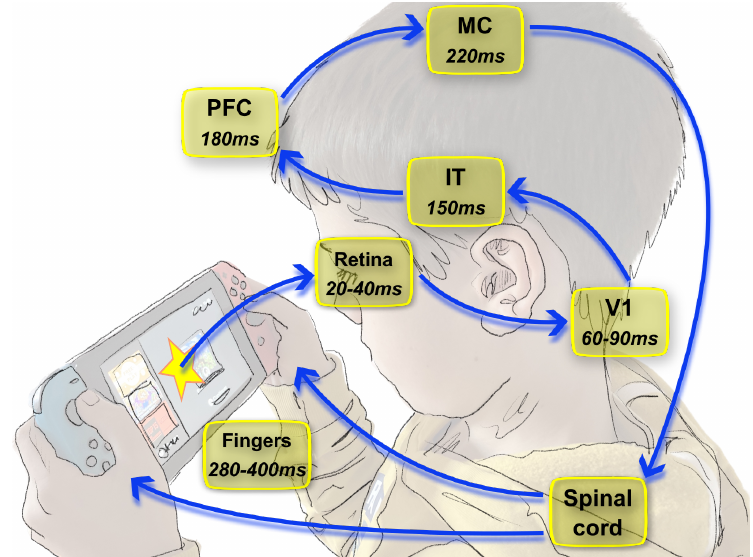
Figure 1. Latency of the different processing steps along the human visual pathway.Though the visual system is highly inter-connected, one can follow the sequence of activations whenever an image (here a yellow star) is flashed in front of the eyes. Different areas are schematically represented by ellipses, and arrows denote the fastest feed-forward activation, ordered with respect to their activation latency in ms. In order, the retina is first activated (20–40 ms), then the thalamus and the primary visual cortex (V1, 60–90 ms). This visual information projects to the temporal lobe to reach the infero-temporal area (IT, 150 ms) for object recognition. It then reaches the prefrontal cortex (PFC, 180 ms), which modulates decision making to evoke the motor cortex (MC, 220 ms) which may mediate an action. This is eventually relayed through the spinal cord to trigger finger muscles, with latencies of about 280–400 ms.